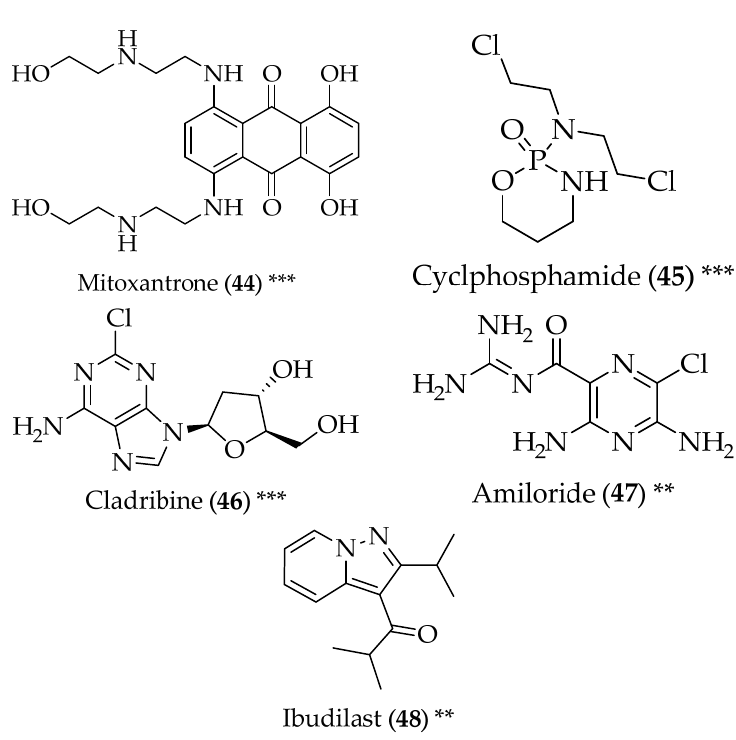
Figure 5. Structure of drugs 44 – 48 (*) Preclinical Studies; (**) Under clinical studies; (***) Clinically approved.